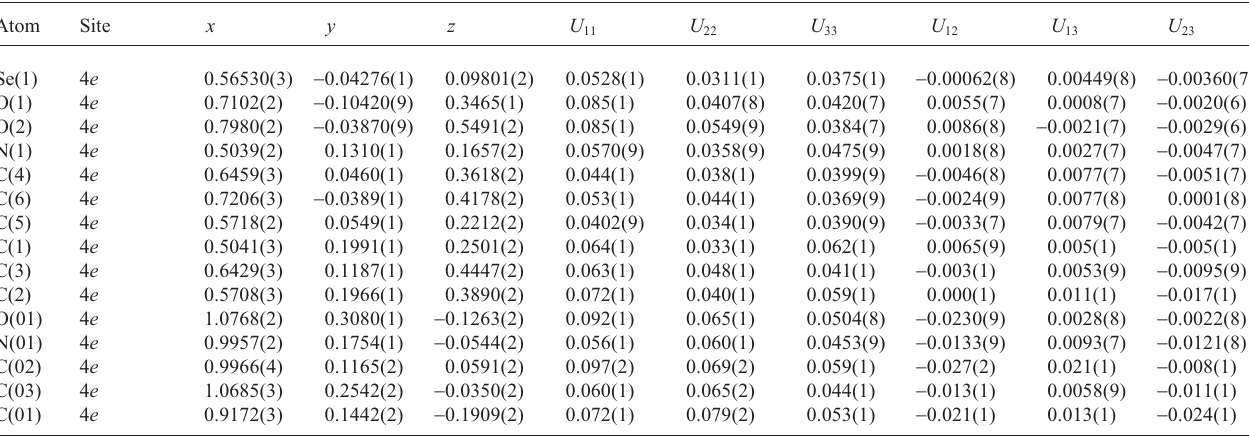
Table 3. Atomic coordinates and displacement parameters (in Å 2 )